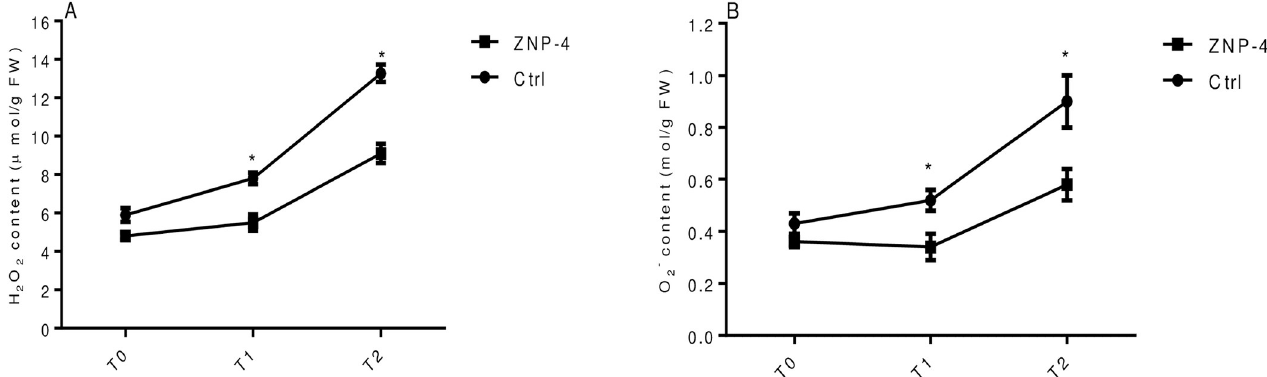
Fig 11. Effect of bacterium inoculation on H 2 O 2 and O 2- level under metal stress (A) H 2 O 2 (B) O 2- content. � represent the significant difference as compared to respective control as per Ducan’s multiple range test (p = 0.05).